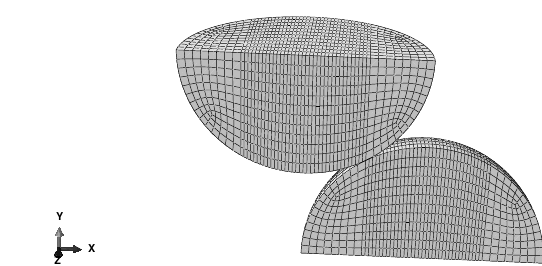
Figure 1 . FEM model for two particles